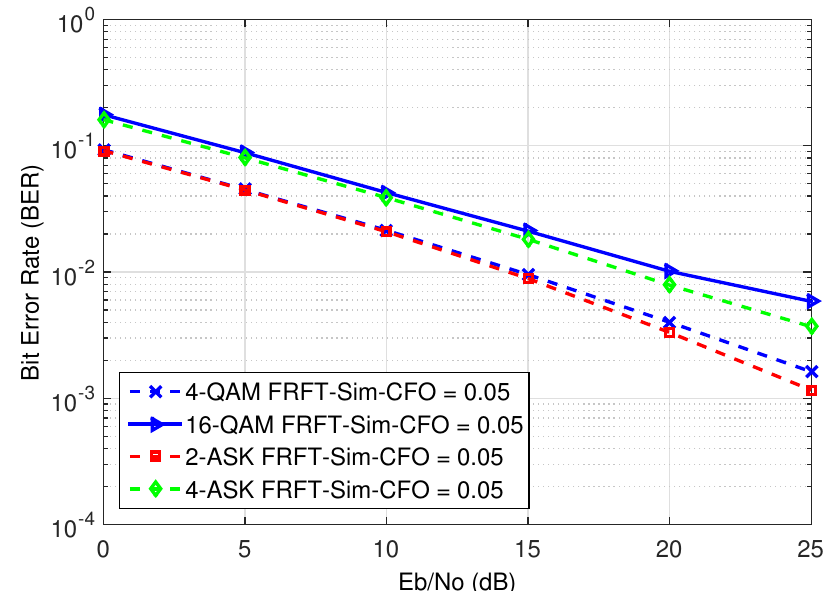
Figure 4. BER performance comparison of M-ary FrFT-ASK-OFDM and M-ary FrFT-QAM-OFDM in the frequency-selective UWA channel with CFO =